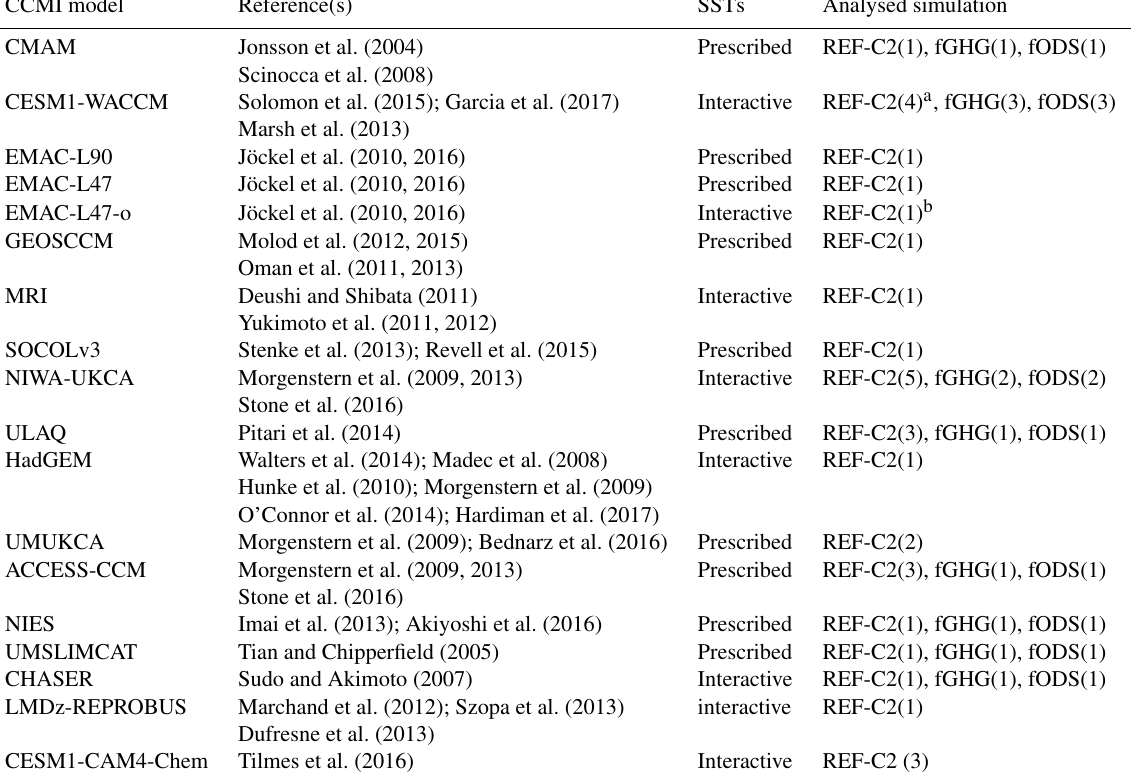
Table 1. Overview of the CCMI simulations, analysed for the present study. For the individual CCMs, their reference(s), their SSTs, and their available simulations (REF-C2, fGHG, fODS) are given. The numbers in brackets behind the simulations indicate the number of realizations of each REF-C2, fGHG, or fODS simulation. Detailed information about the models’ SSTs and the models’ representation of the QBO is given in the Supplement of Morgenstern et al.